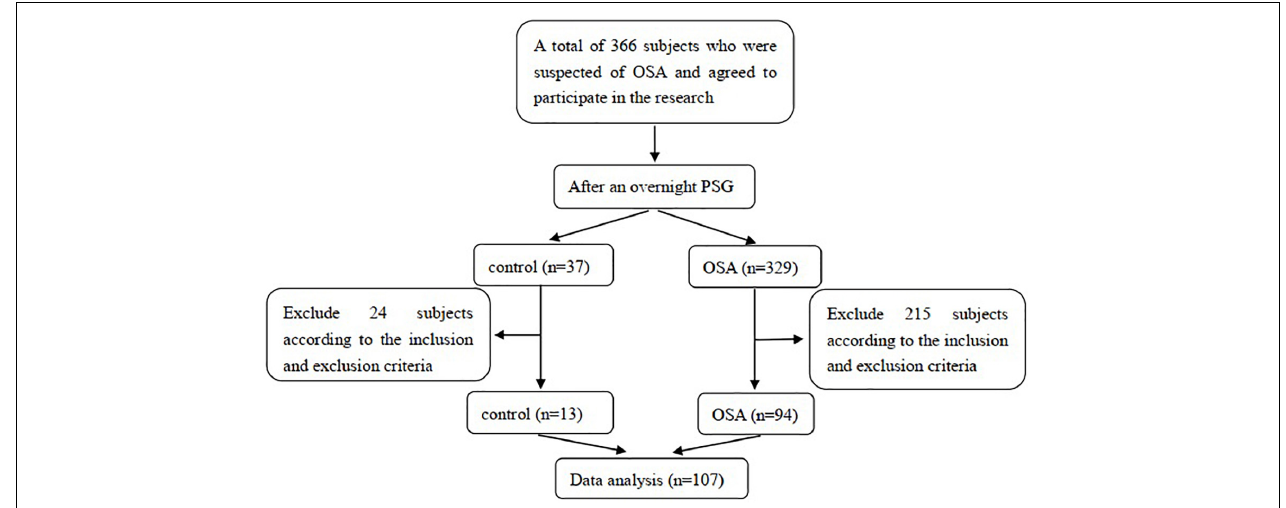
FIGURE 1 | The process of subjects